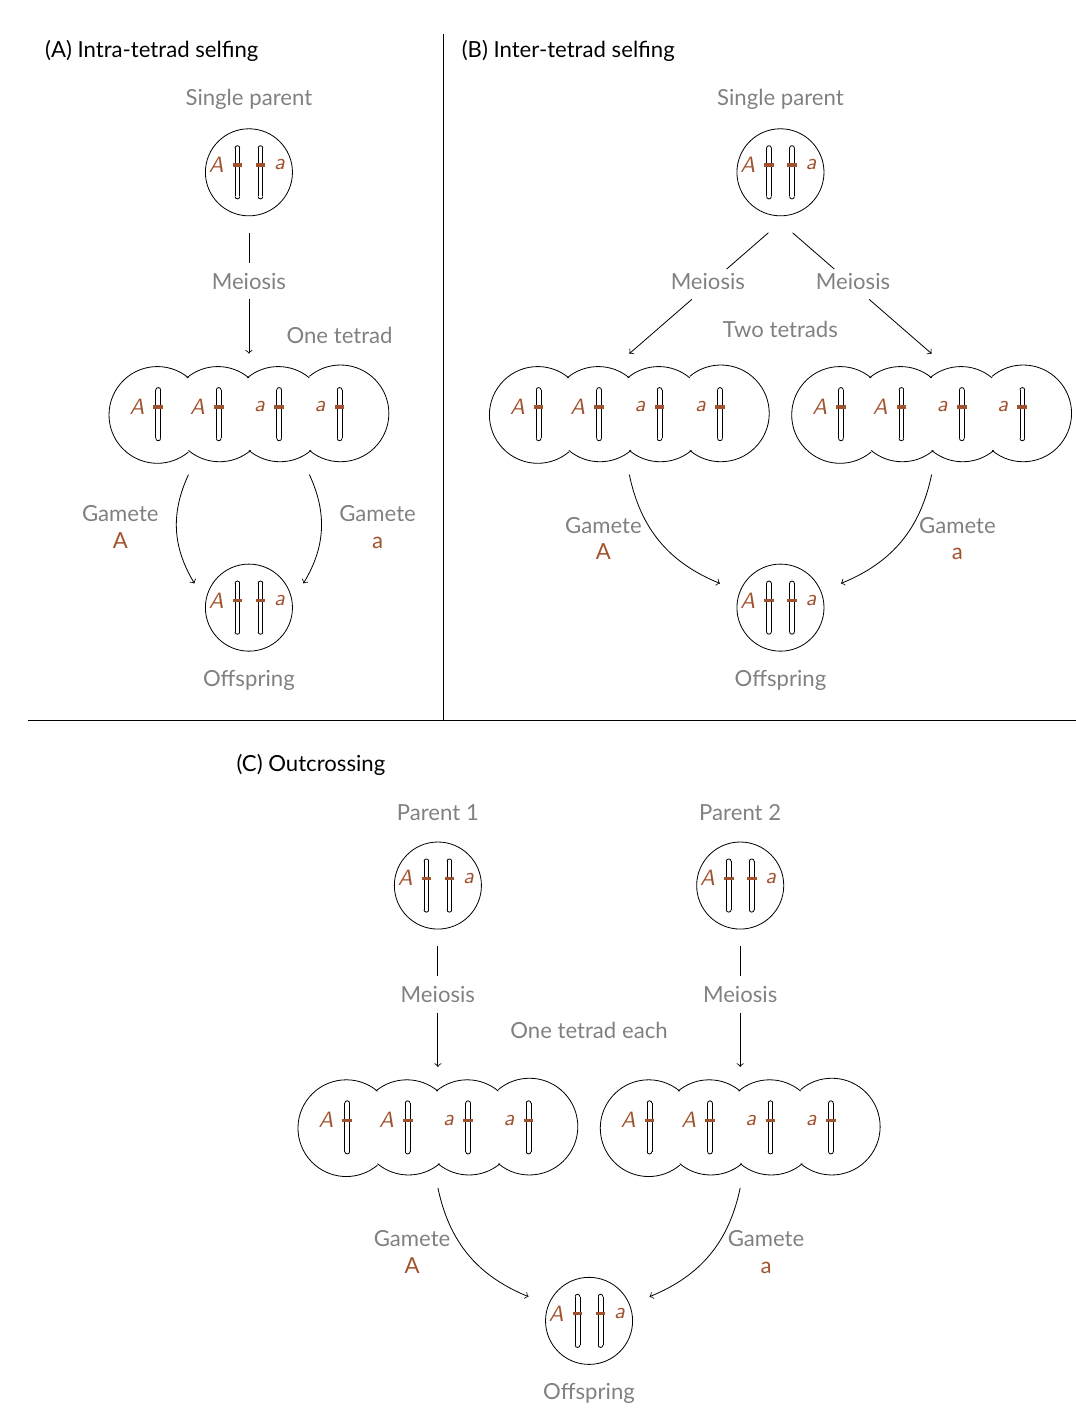
Figure S1 – Schematic representation of the three mating systems considered in the model. Individuals are represented by a pair of mating-type chromosomes, with the mating-type locus displayed. A diploid offspring is generated by the fusion of two ga- metes carrying different mating-type alleles (A and a). (A) Under intra-tetrad selfing, both gametes are picked from the same tetrad; only one parent is involved. (B) Under inter- tetrad selfing, the two gametes are picked from two different tetrads (meioses) produced by the same diploid parent; only one parent is involved. (C) Under outcrossing, the two gametes are picked in tetrads produced by different